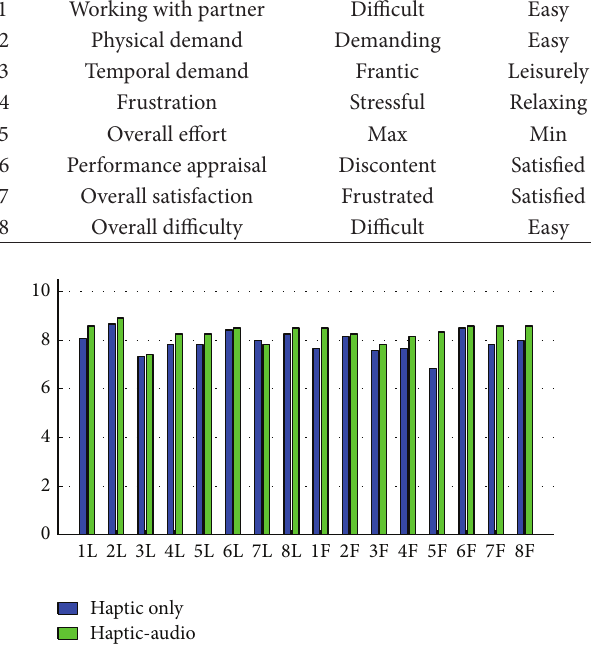
Figure 2: The mean responses of leaders (L) and followers (F) to the 8 questions in the modified NASA Task Load Index (TLX) survey in Table